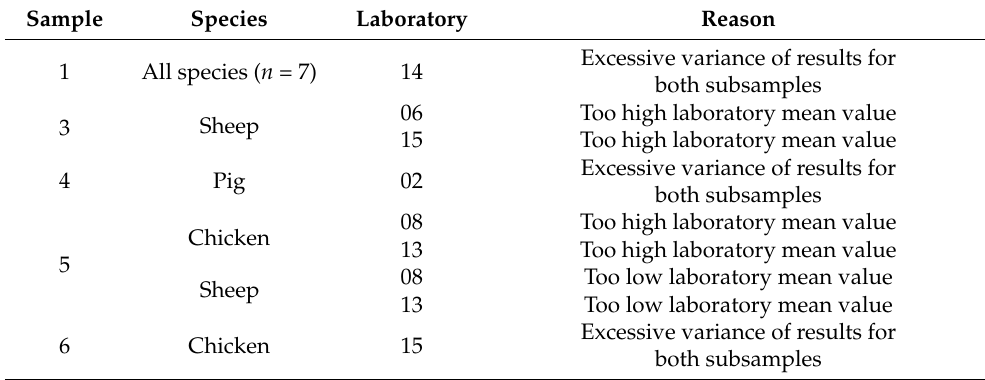
Figure 1. Proportions of animal species determined for samples 3, 4, 5, and 6. ( A ) AGES database, ( B ) NCBI database. Laboratories 01–06, 08, 14, 15: MiSeq; laboratories 07, 13, 20: iSeq 100; laboratories 09–12: Ion GeneStudio S5. Table 3. Summary of eliminated